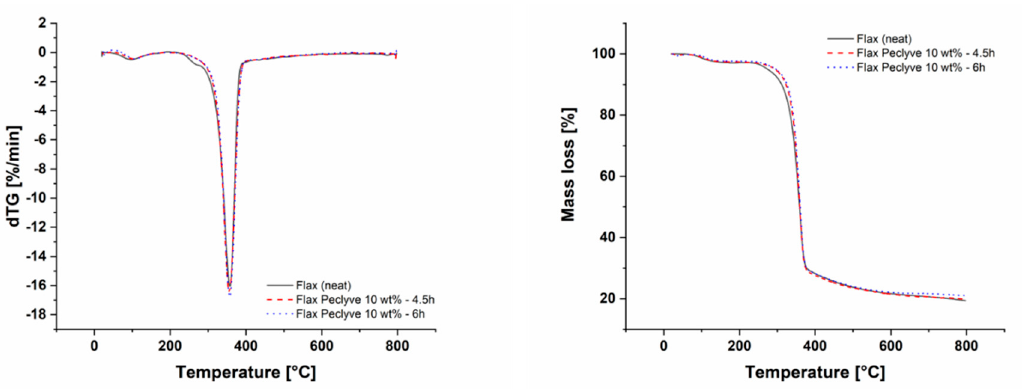
Figure 7. Derivative thermogravimetry (dTG) curves and thermogravimetric analysis (TGA) thermograms of flax yarns before and after enzymatic treatment.